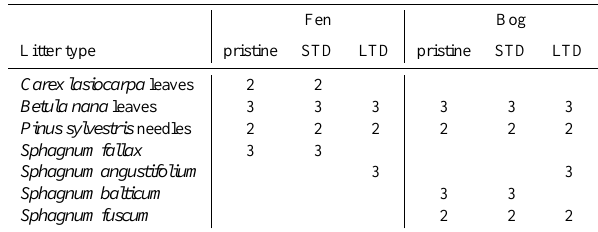
Table 1. Experimental layout: litter types included in this study, and the number of replicate litterbags per litter type, plot (water table regime) and site (nutrient regime: fen and bog) prepared for annual recovery. Litter of Betula nana and Pinus sylvestris was present at all sites and plots (common litter) while the other litter types were typical of certain sites or plots (specific litter). The samples repre- sent a subset of an ongoing long-term decomposition study.